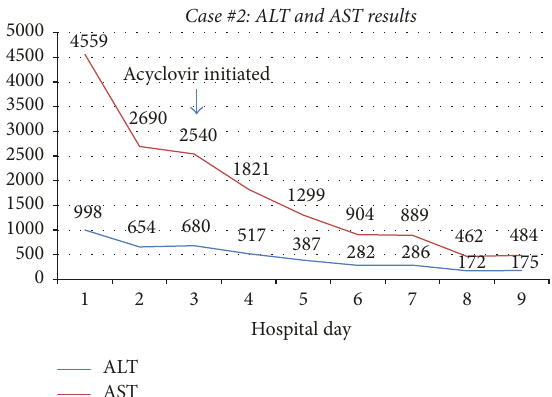
Figure 3: Case #2 trend in AST and ALT. ALT: alanine aminotrans- ferase; AST: aspartate aminotransferase.